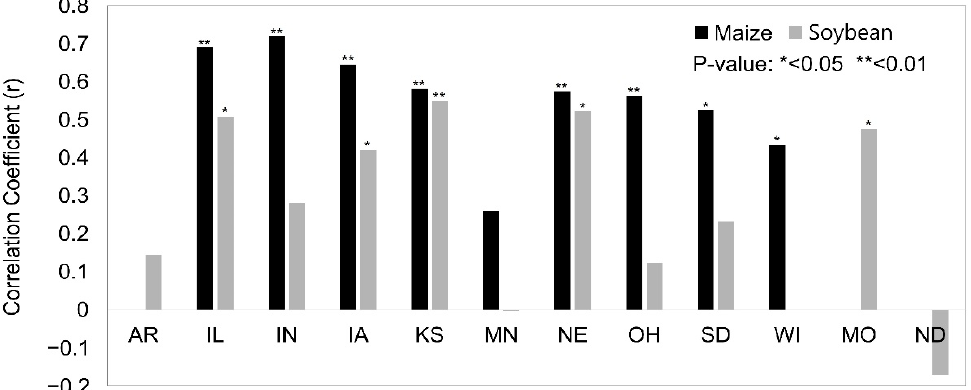
Figure 6. Correlations of state-level maize and soybean yields with GPP for the average of July–August (detrend).